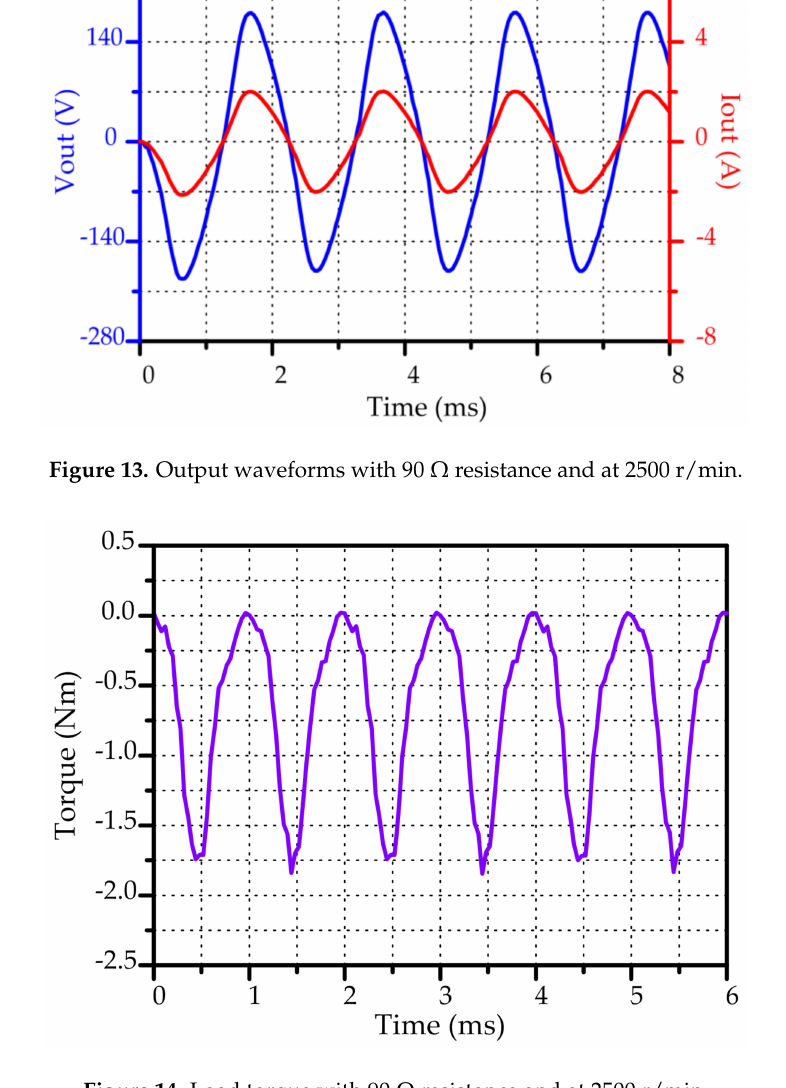
Figure 14. Load torque with 90 Ω resistance and at 2500